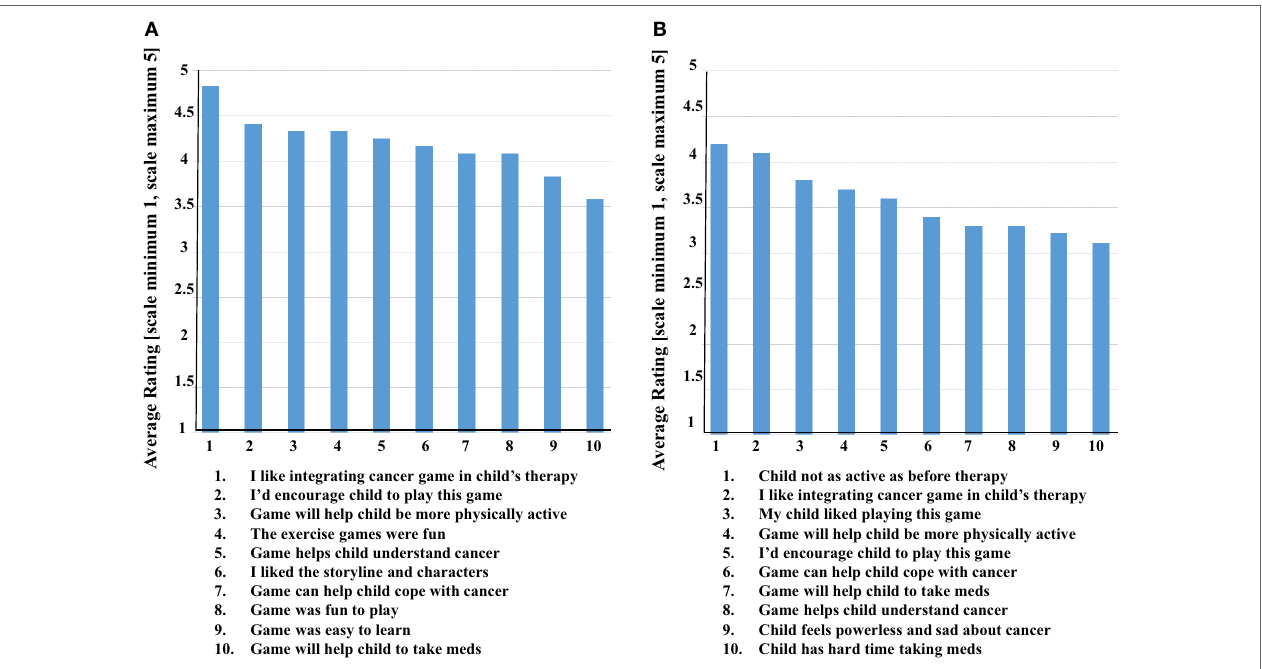
FigUre 12 | Health-care providers and parents each completed a 10 question Likert scale, which contained five unique and five overlapping questions. (a) The mean ratings of health-care providers ( n = 12) were above 3.5 in all categories, with the top-rated being liking the idea of integrating a cancer-focused video game into the overall therapy for a child with cancer. (B) The mean ratings of parents ( n = 10) were somewhat lower though all still above 3.0. The top-rated statement identified their child is not being as physically active as before the diagnosis and initiation of cancer treatment, followed very closely by liking the idea of integrating a cancer-focused video game into the overall therapy for their child with cancer.